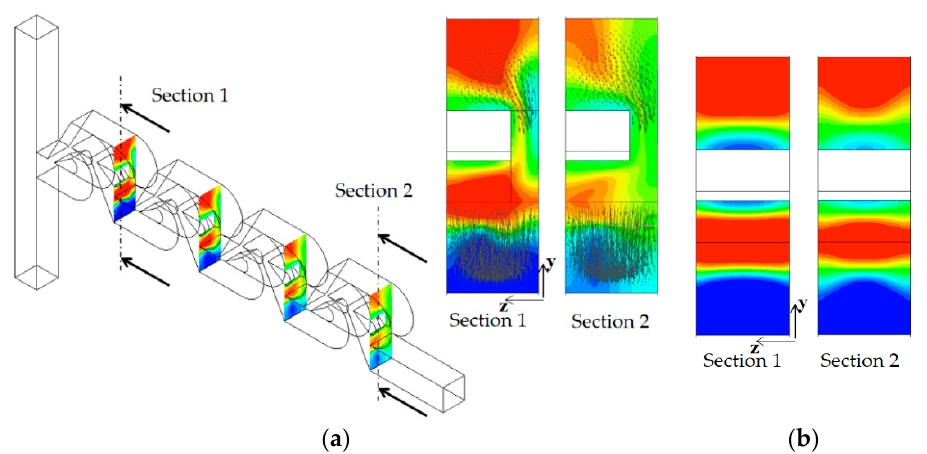
Figure 12. Evolution of mixing and velocity vector on the yz planes for Re = 0.1: ( a ) tip clearance h = 60 μ m and ( b ) no tip clearance.